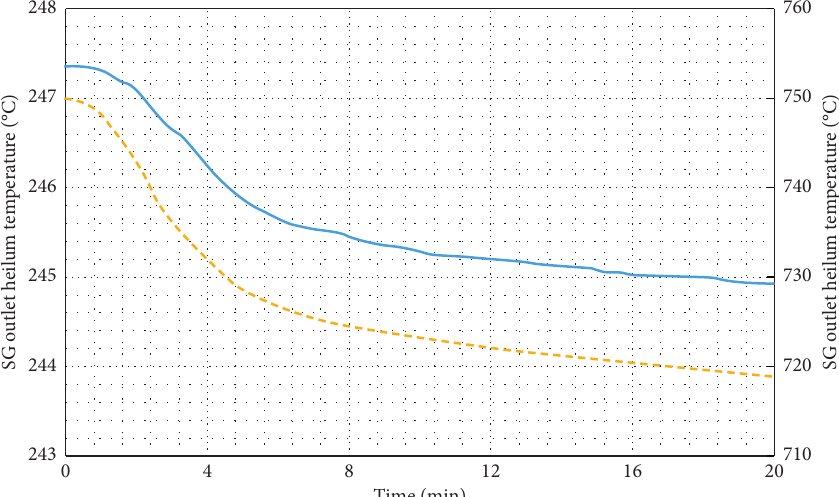
Figure 17: SG outlet and inlet helium temperature of #2 module in case 2 (solid line: outlet; dashed line: